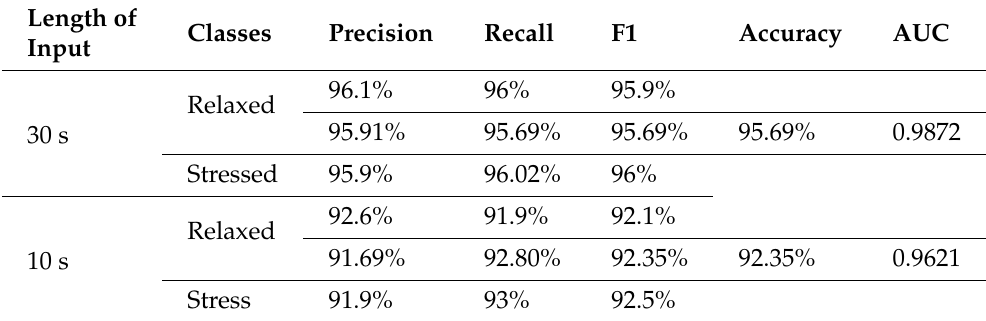
Table 6. Performance of the suggested method’s classification depending on input signal